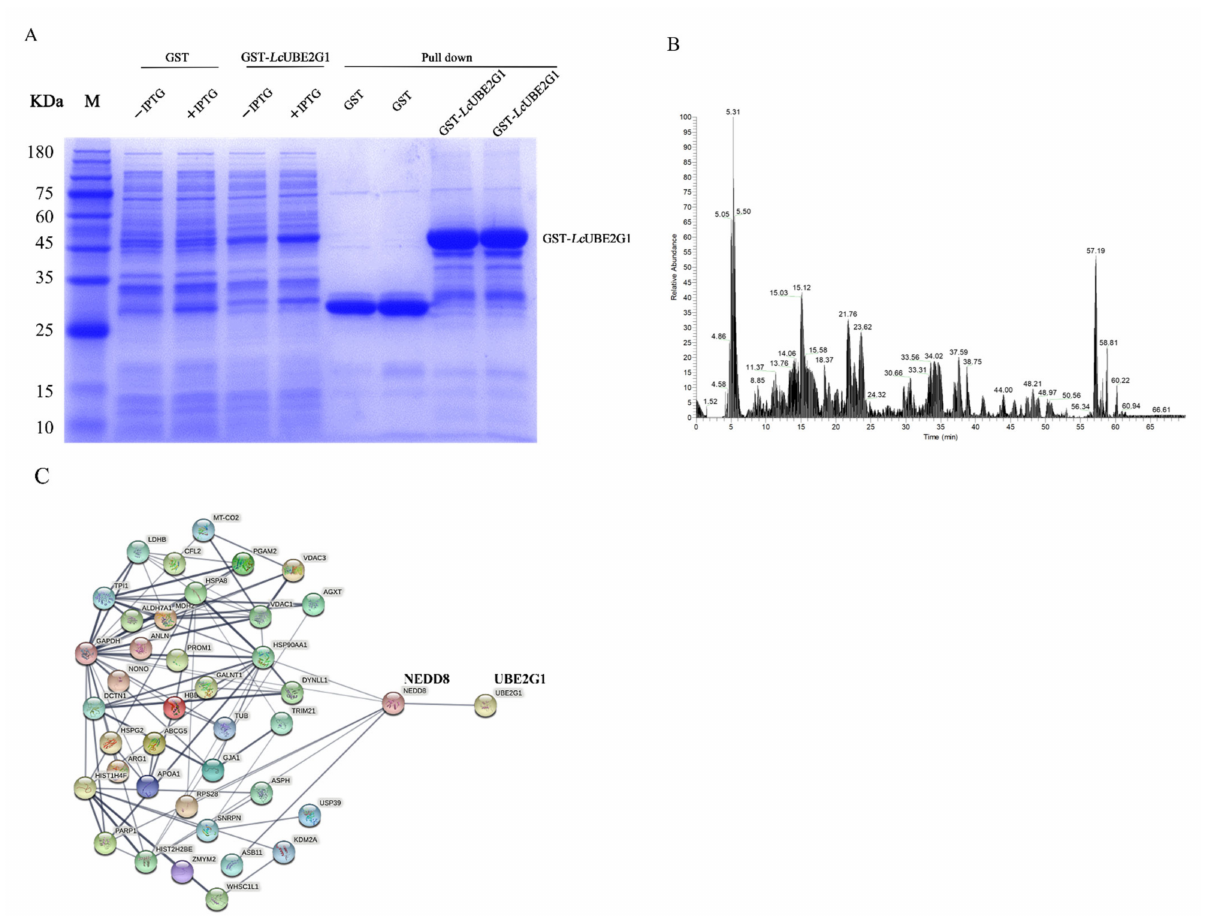
Figure 7. ( A ) SDS-PAGE analysis of GST pull-down results of recombinant Lc UBE2G1 fusion protein; ( B ) GST pull-down protein mass spectrometry results; ( C ) STRING analysis of proteins obtained by mass